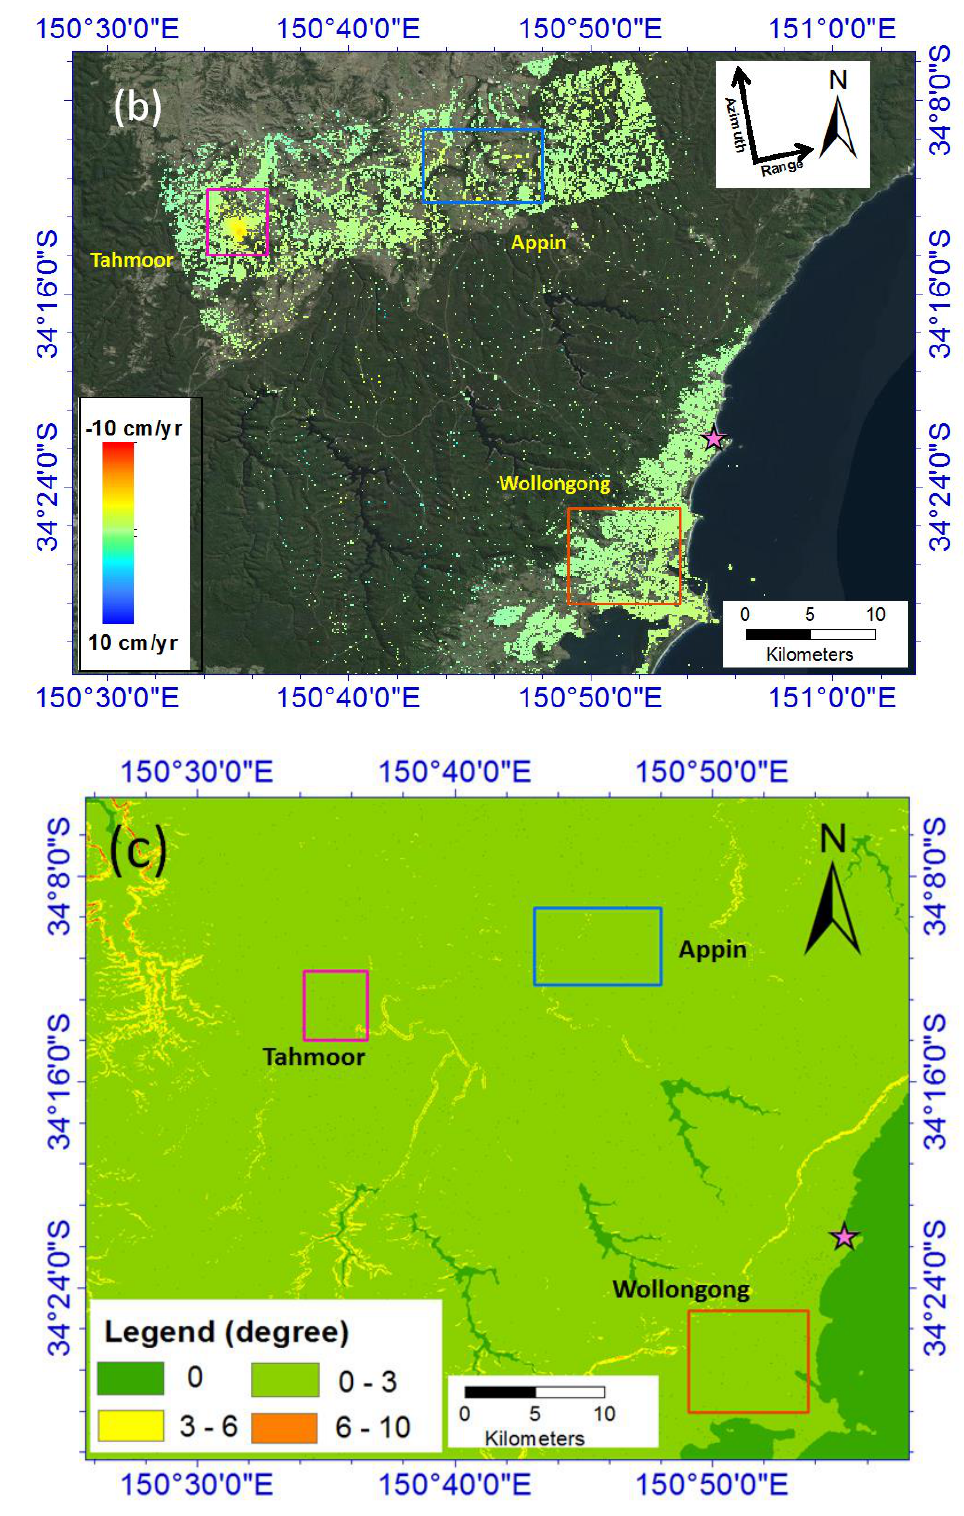
Figure 2. ( a ) ALOS-1 PALSAR mean velocity result in LoS direction; ( b ) ENVISAT ASAR mean velocity result in LoS direction. The pink star represents the reference point while regions marked with red, blue and purple rectangular boxes are Wollongong city area, Appin mining sites and Tahmoor town region, respectively. The displacement results are resampled to a grid of 100 m × 100 m resolution; ( c ) Slope Map generated from SRTM DEM.